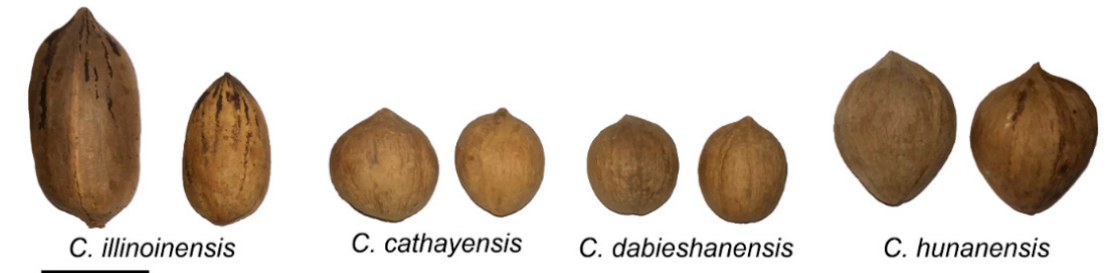
Figure 1. The nuts of four Carya species. The scale is one centimeter.